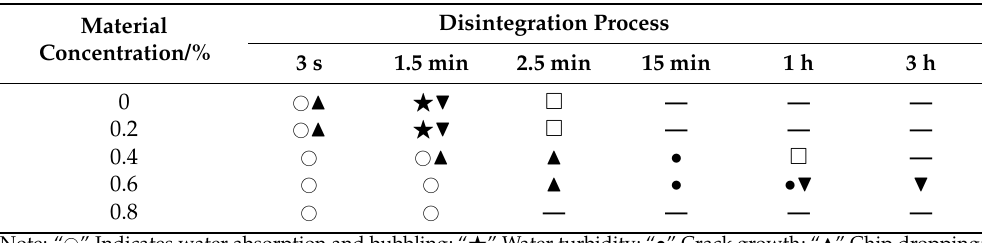
Table 3. Sample disintegration